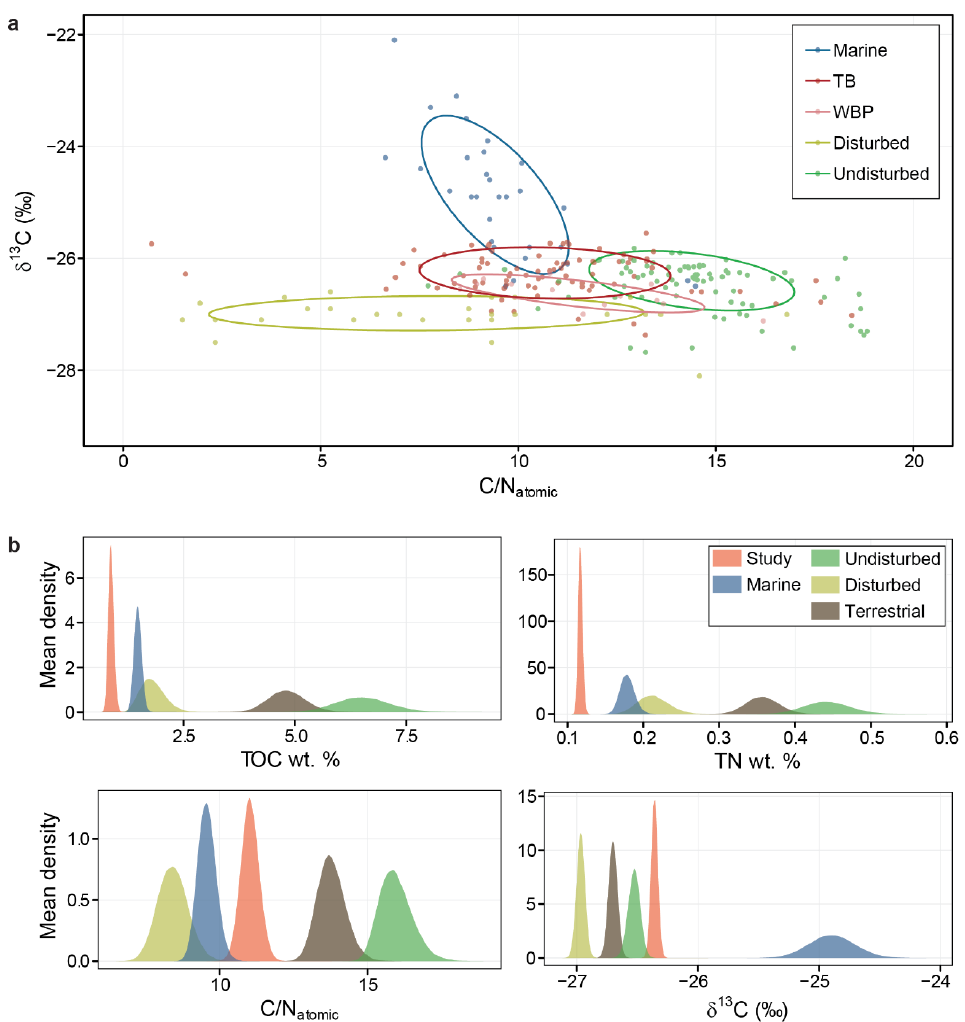
Figure 4. ( a ) Scatterplot showing the relation of stable carbon isotopes (δ 13 C) and atomic organic carbon-nitrogen (C/N) ratios along with concentration ellipses of one standard deviation, ( b ) boot- strap kernel density plot of parameter means. Shown are results of the current study localities of Thetis Bay and Workboat Passage (TB and WBP) and results from other studies in the region that focused on marine sediments (here 25 km offshore in the Beaufort Sea) (Naidu et al. [38], as well as sediments from disturbed and undisturbed landscapes on Herschel [34,77,78,83]. Disturbed and un- disturbed sediments are combined under “terrestrial”. δ 13 C values are expressed as ‰ relative to the Vienna Pee Dee Belemnite (VPDB) standard.